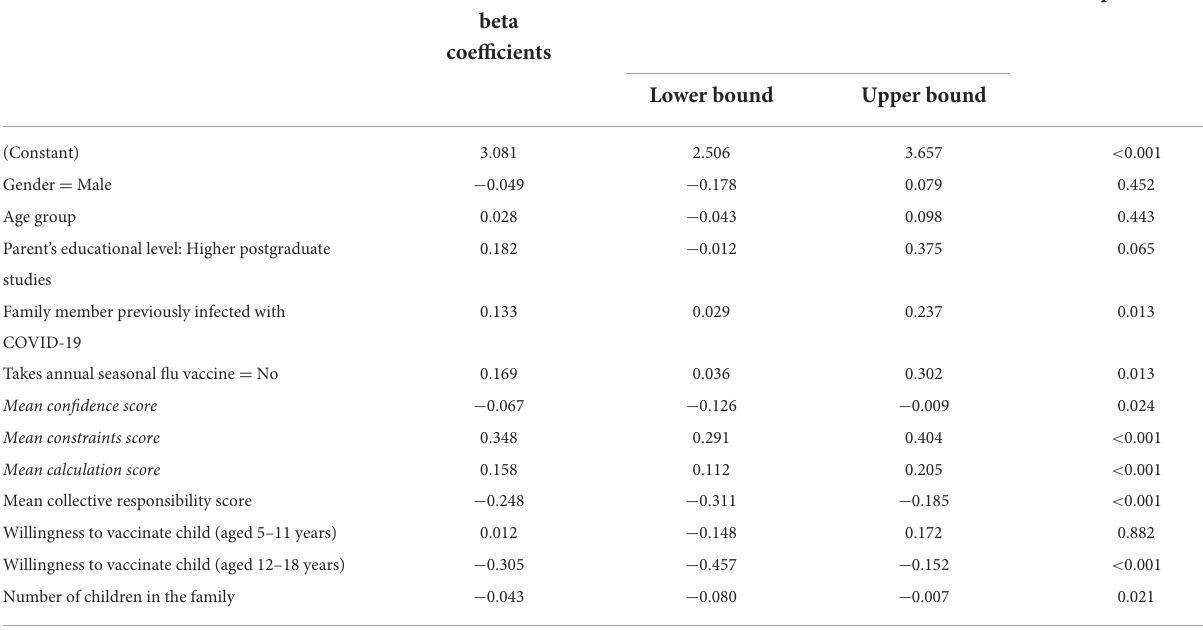
TABLE 2 Multivariate linear regression analysis of parents’ complacency as scored by the 5C Scale.